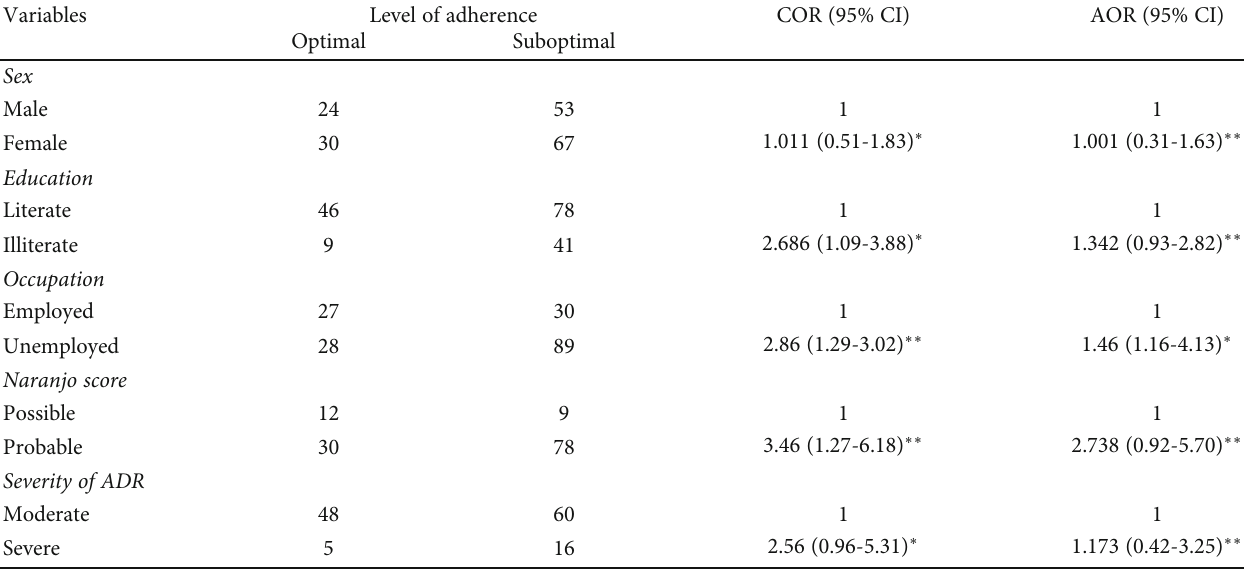
Table 6: Factors associated with medication